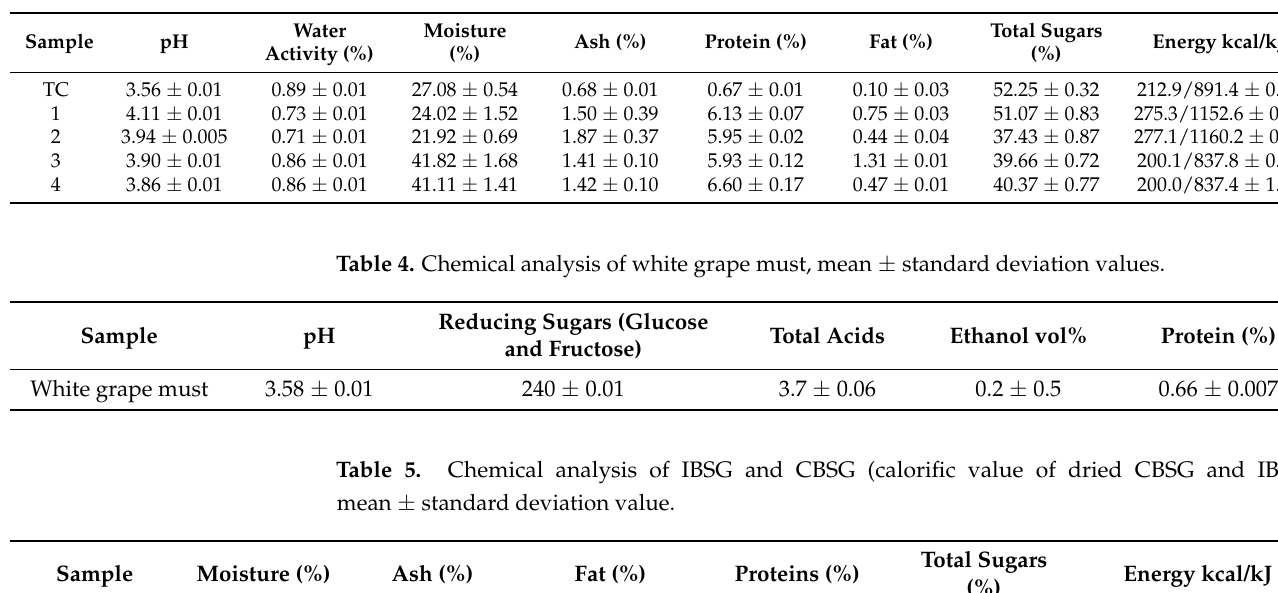
Table 3. Results of nutritive and chemical composition of TC and ´cupter with BSG (Samples 1, 2, 3, 4), mean ± standard deviation values.